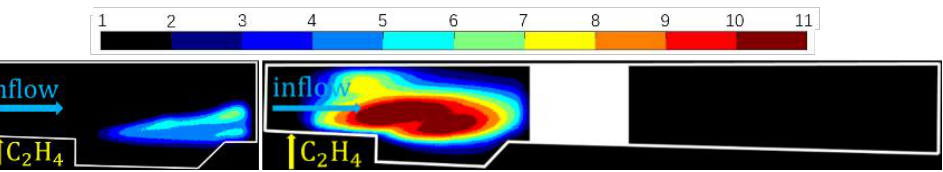
Figure 13. Standard deviation pseudo-color image of CH* chemiluminescence at Case 11 (1.7D 0 I0.144) (left) and Case 13 (1.7D 0 I0.169) (right).